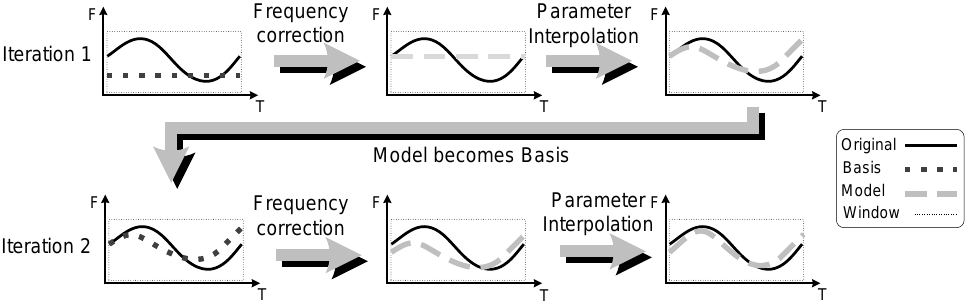
Figure 3. Illustration of the adaptation of the frequency trajectory of a sinusoidal partial inside the analysis window in eaQHM. The figure depicts the first and second iterations of eaQHM around the loop in Figure 2, showing local adaptation as the iterative projection of the original waveform onto the